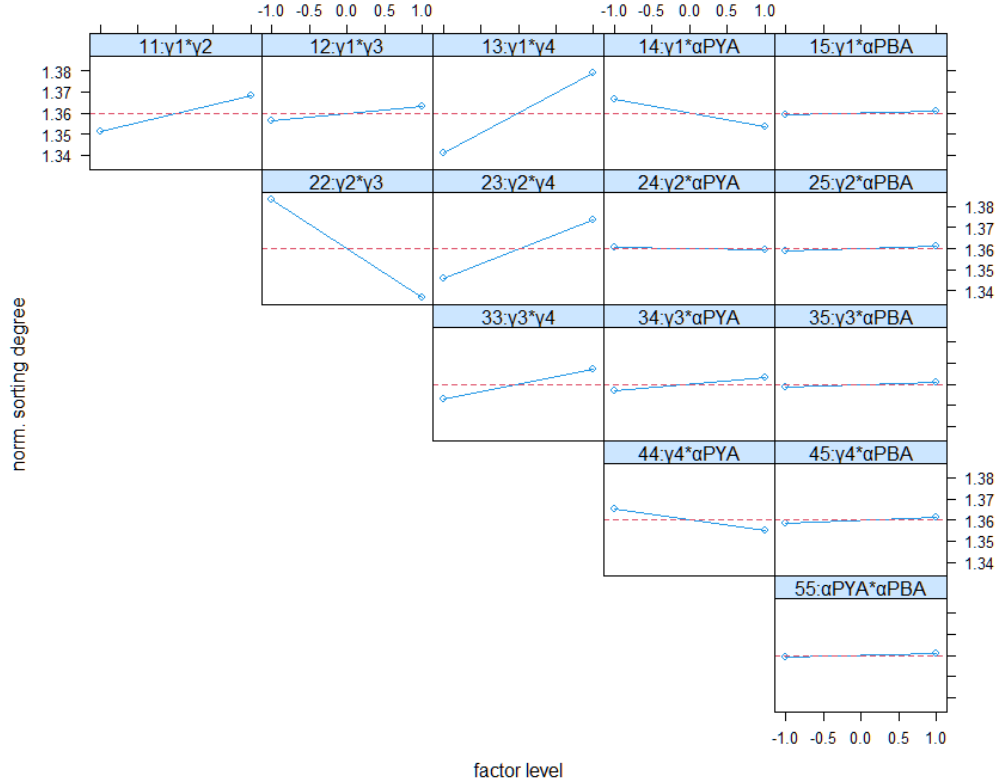
Figure 15. Interactions on norm. Sorting degree in the real-data-based model.